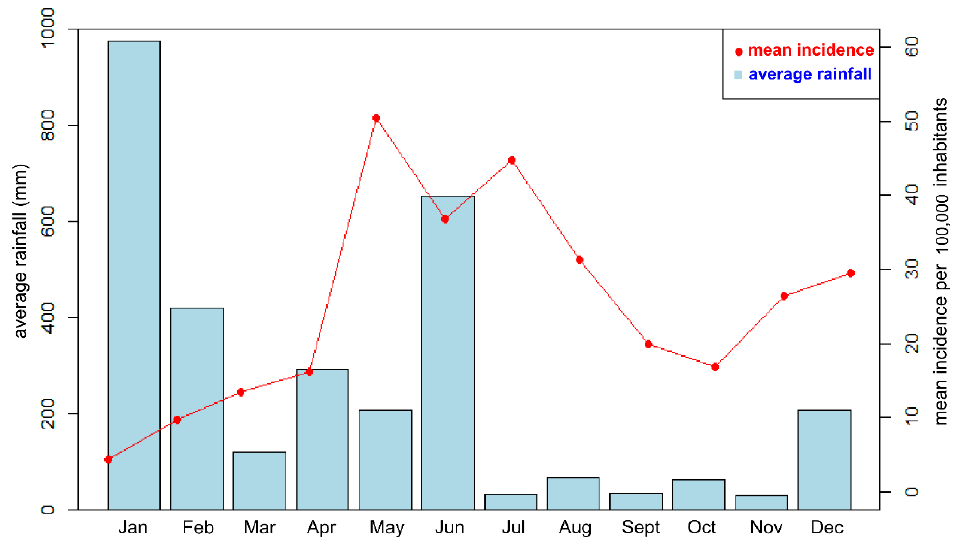
Figure 3. Monthly malaria incidence in Grande Comore and average rainfall in Moroni in 2016.